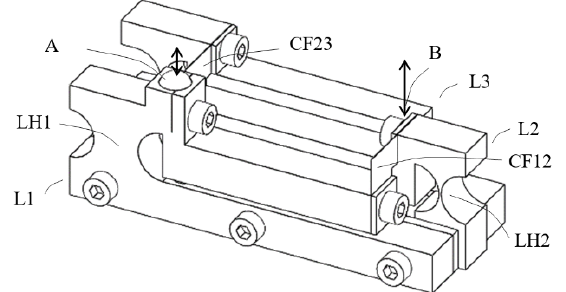
Figure 8. The conceptual Design C.